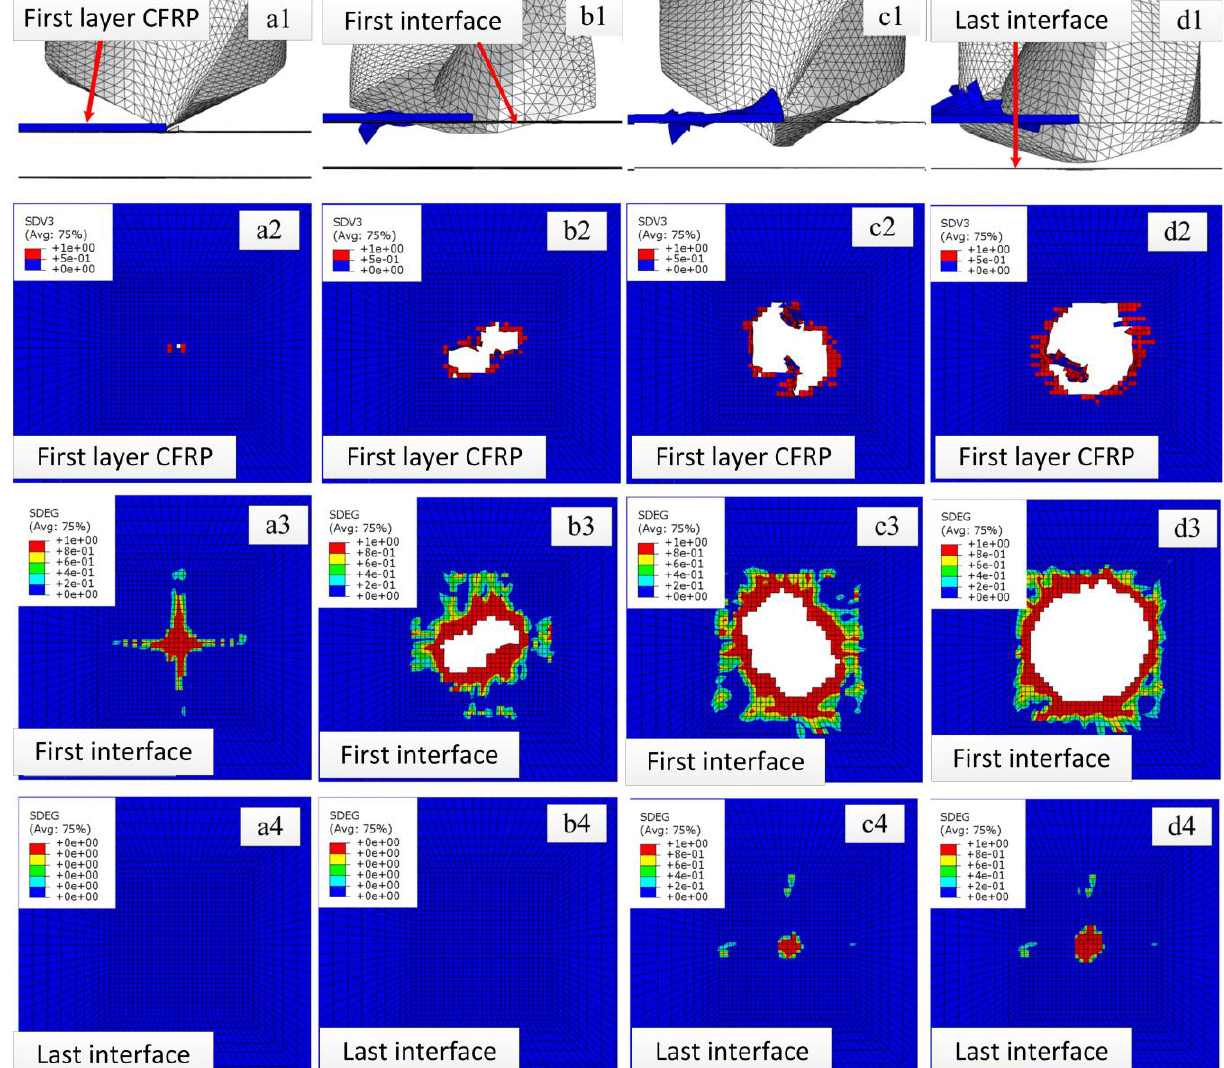
Figure 4. Representative figures of drill bit passing through every layer of CFRP and every layer interface of drilling simulation results at different stages. ( a1 – a4 ) Drilling stage I. ( b1 – b4 ) Drilling stage II. ( c1 – c4 ) Drilling stage III. ( d1 – d4 ) Drilling stage IV.